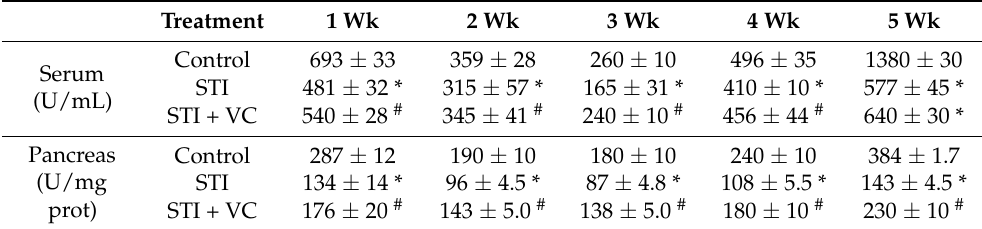
Table 6. GSH-Px activity in the serum and